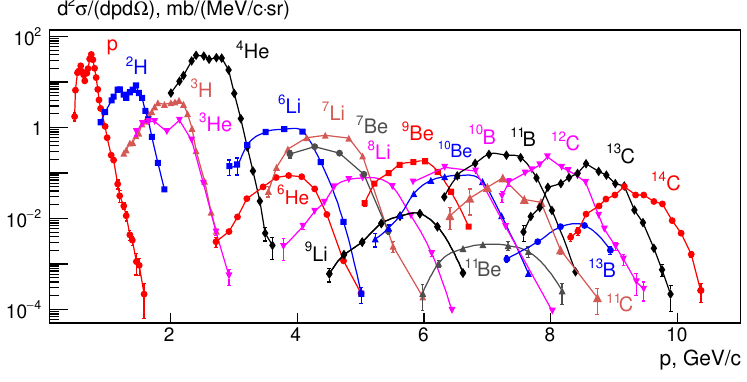
Figure 1. Di ff erential cross sections for the yield of fragments as a function of the laboratory momen-